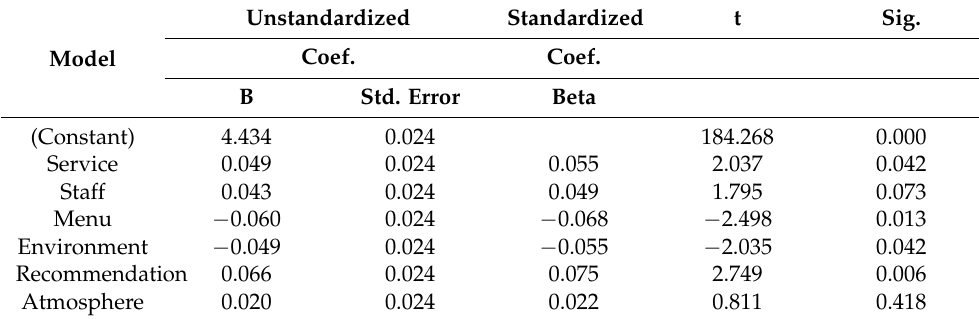
Table 6. Results of linear regression